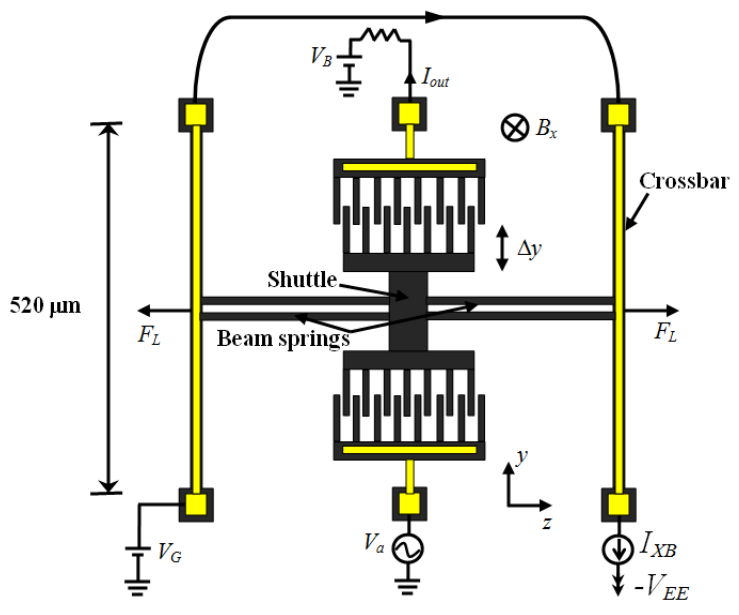
Figure 14. Schematic view of electrostatic resonator used as magnetic field sensor by Bahreyni et al .